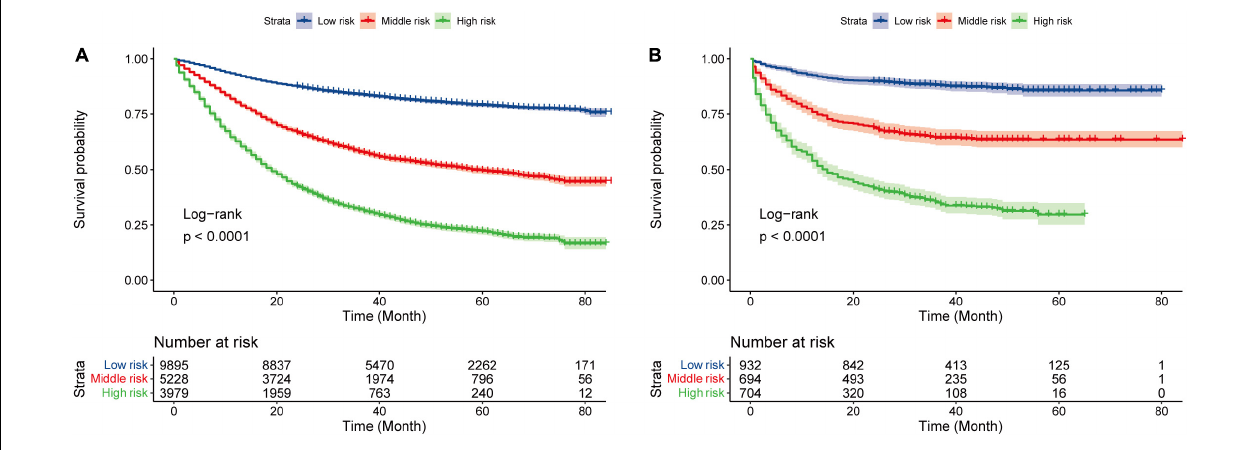
FIGURE 4 | Kaplan–Meier curves for three groups. Kaplan–Meier curves for three groups in the training cohort (A) and the validation cohort (B)